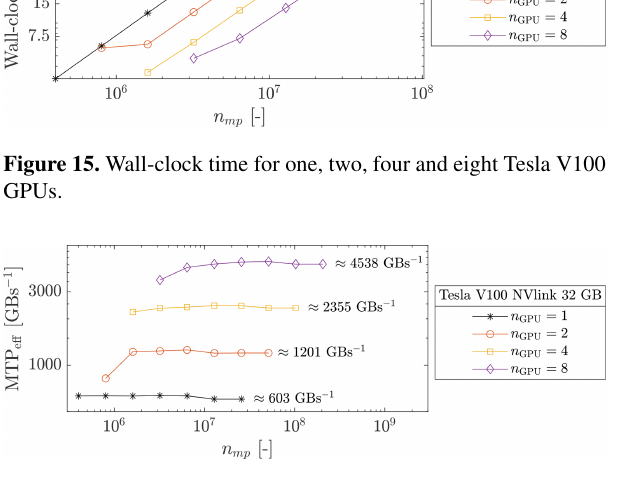
Figure 16. Sum across the GPUs involved of the MTP eff . We roughly report a weak scaling between the number of GPUs and the overall effective memory throughput.